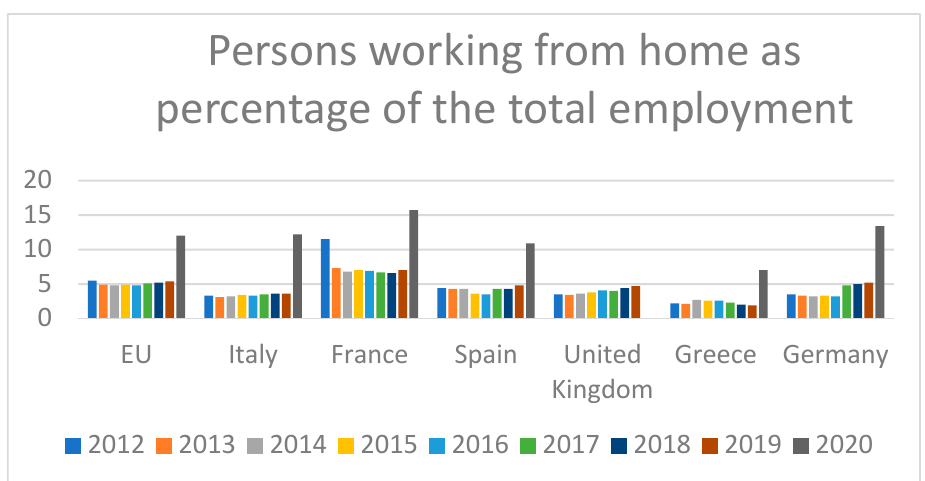
Figure 2. Employees working from home as a percentage of total employment [4].